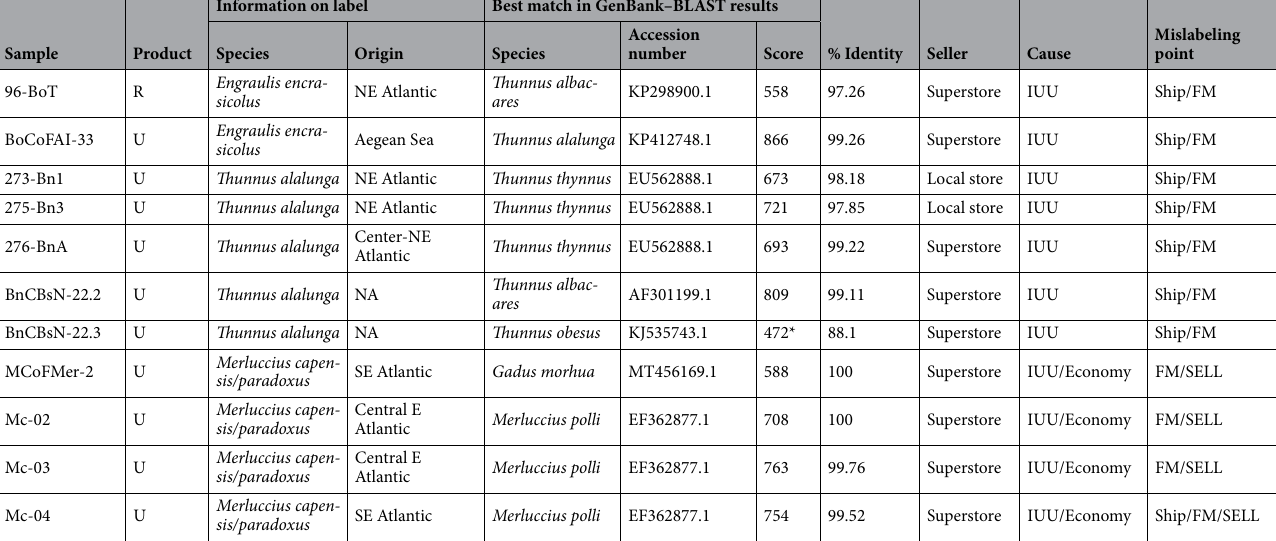
Table 2. Mislabeled and substitute species. Sample code, product type (R: recognizable, U: unrecognizable), information on the label, BLAST results (species, accession number, score and % of identity with the best match), selling point (seller), inferred mislabeling cause (IUU as illegal, unreported and unregulated fishing) and inferred point in the commercial chain where the substitution took place (FM as fishmonger or retailer, SELL as selling point). Score < 500 marked as *. NA: not available. R, recognizable; U,